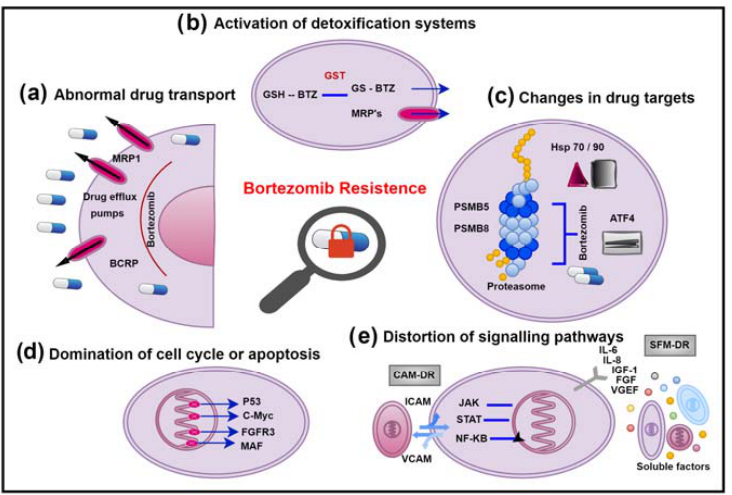
Figure 1. Bortezomib resistance mechanisms in MM. ( a ) Abnormal drug transport. ( b ) Activation of detoxification systems. ( c ) Changes in drug targets. ( d ) Domination of cell cycle or apoptosis. ( e ) Distortion of signalling pathways.